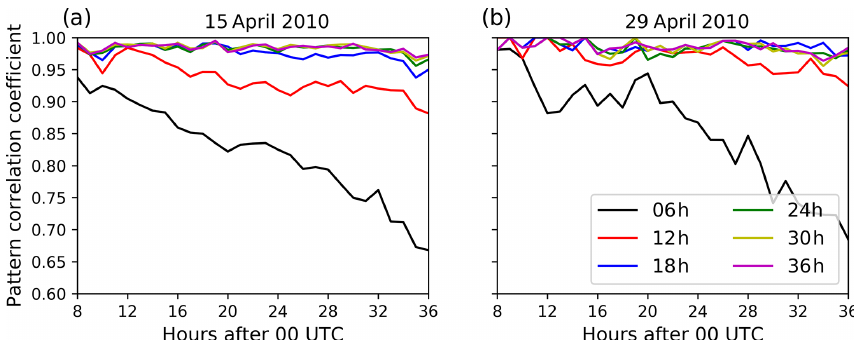
Figure 6. Pattern correlation coefficient defined by Eq. (7) for the eruption on (a) 15 April 2010 and on (b) 29 April 2010. The different lines indicate different assimilation window lengths from 6h (gray) to 36h (magenta) as defined by Fig. 3.